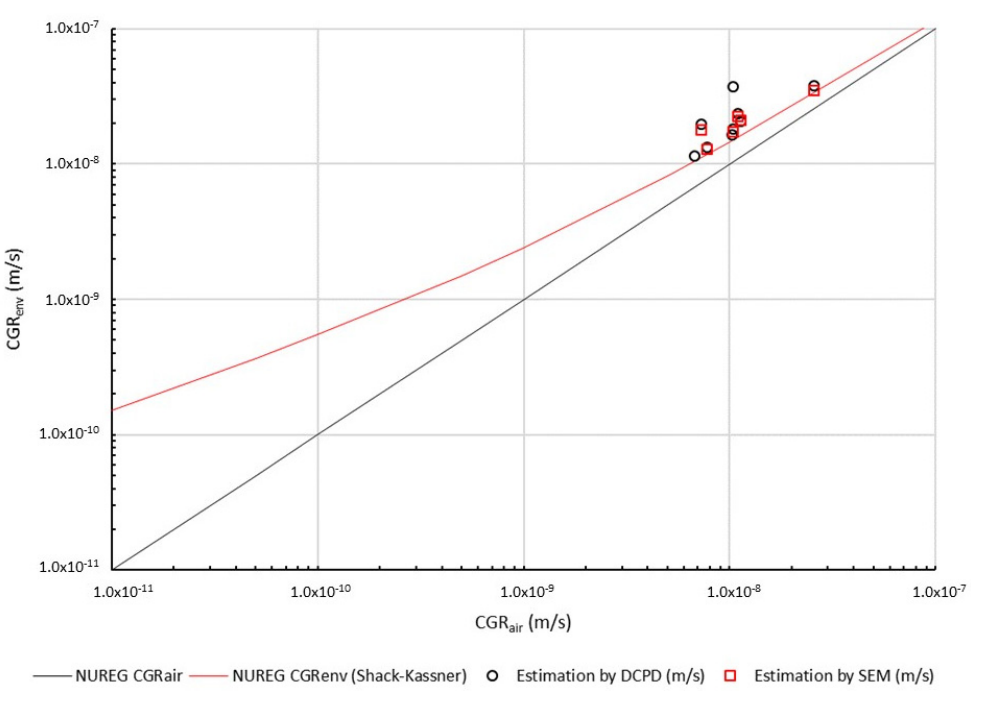
Figure 10. CGRs (obtained by DCPD and SEM fractography) compared with the curves proposed in NUREG/CR-6909 (air and PWR environment).